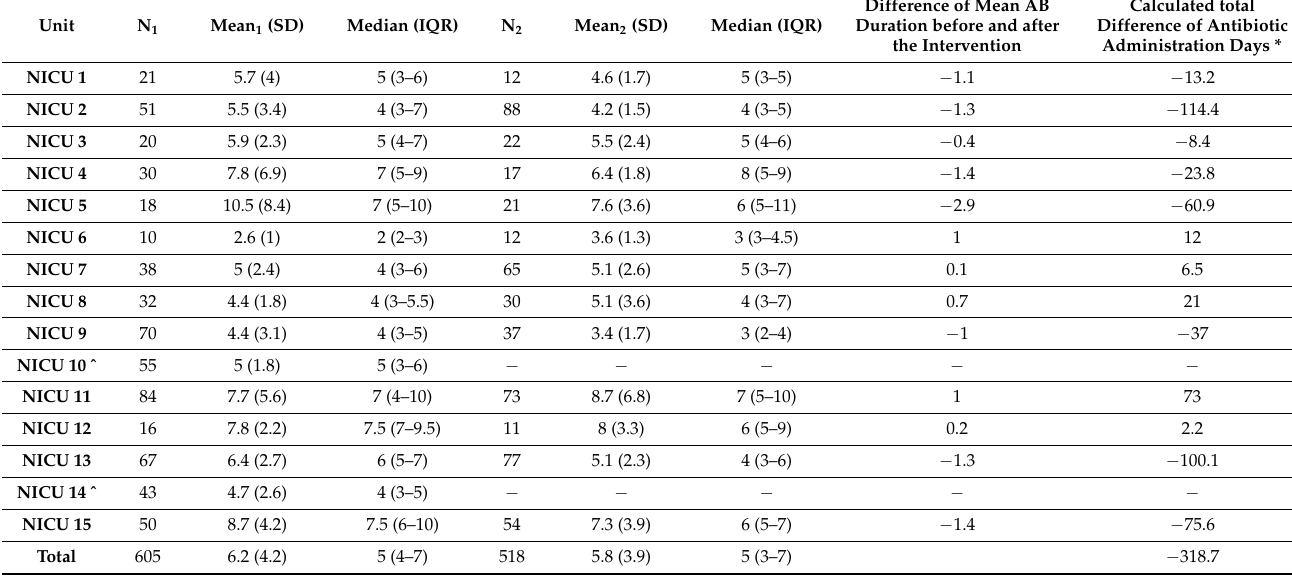
Mean 1 : Mean length of therapy before intervention. Mean 2 : Mean length of therapy after Intervention. * (Mean 1 -Mean 2 ) × number of neonates meeting intervention criteria in the post-intervention period (N 2 ). IQR: Inter-quartile range. ˆ unit did not proceed to the intervention phase. AB: antibiotic.